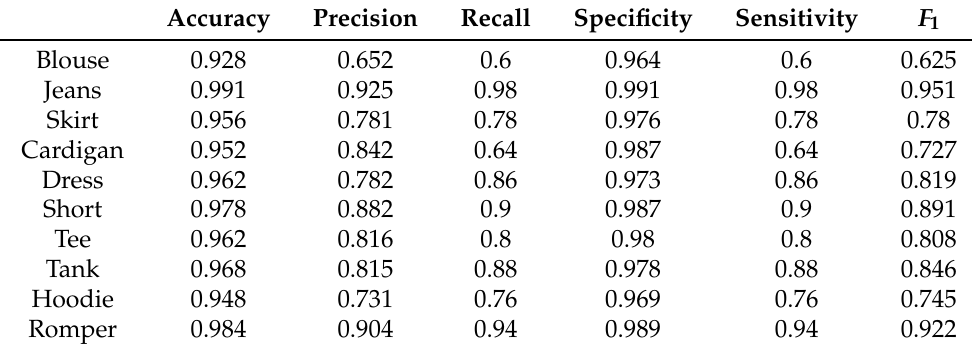
Table 5. Performance of EnCaps in the accuracy, precision, recall, specificity, sensitivity, and F 1 metrics. Accuracy Precision Recall Specificity Sensitivity F